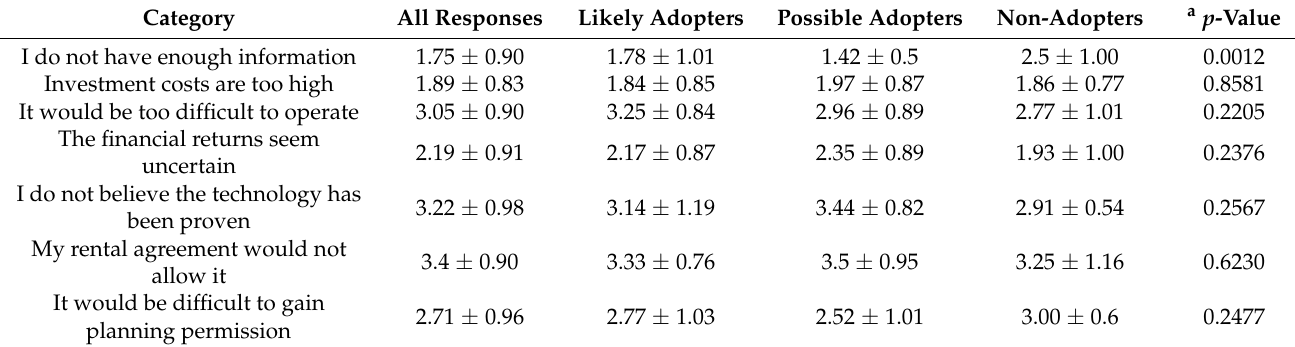
Table 3. Summary of survey responses to Likert-scale questions on the importance of potential AD